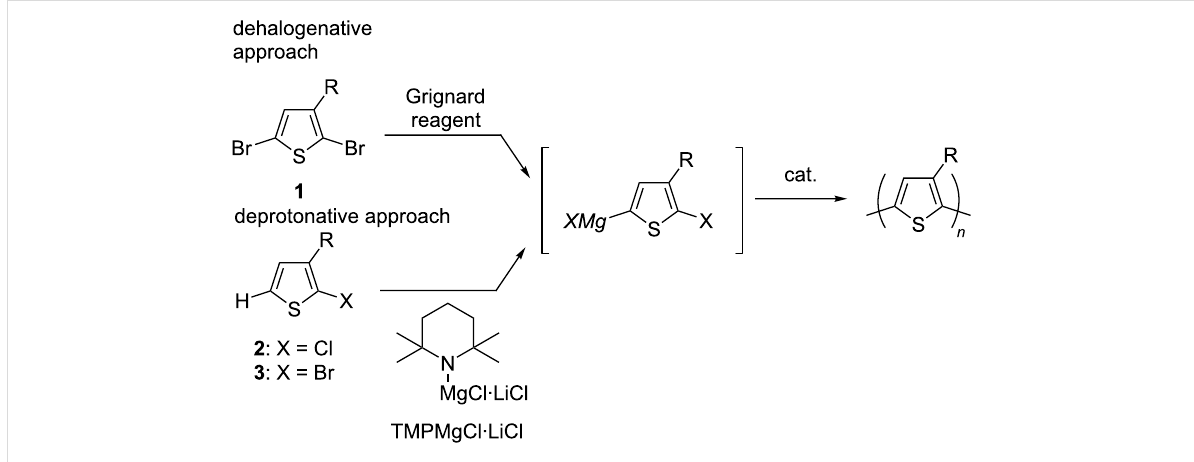
Scheme 1: Cross-coupling polymerization of thiophene.